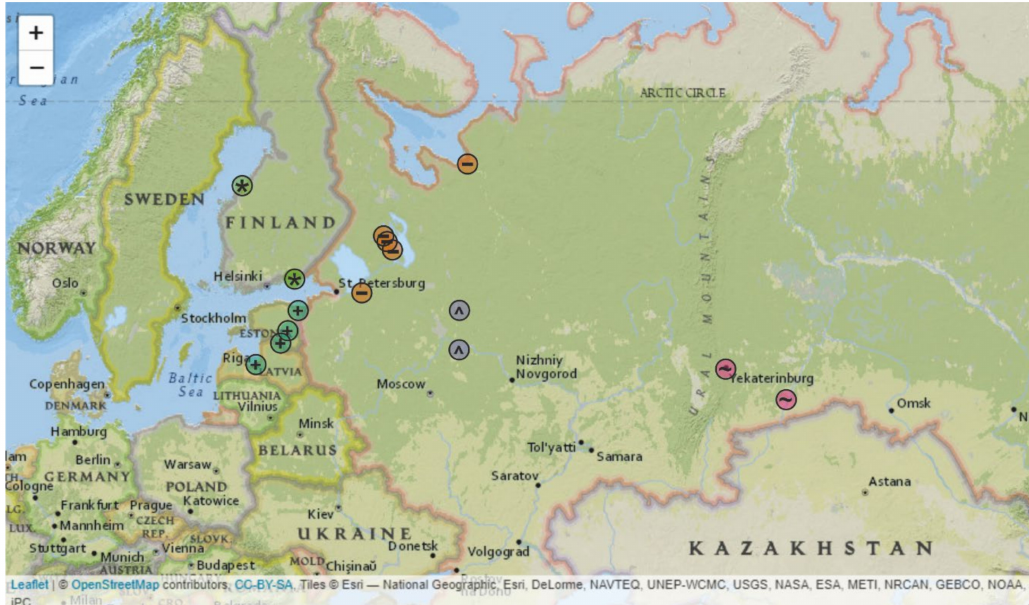
Figure 1. Known distribution of the Baltic subgroup in Siberian TBEV subtype (Baltic TBEV-Sib). Interactive map with labelled markers is available at [30]. Places of tick collection were colour-